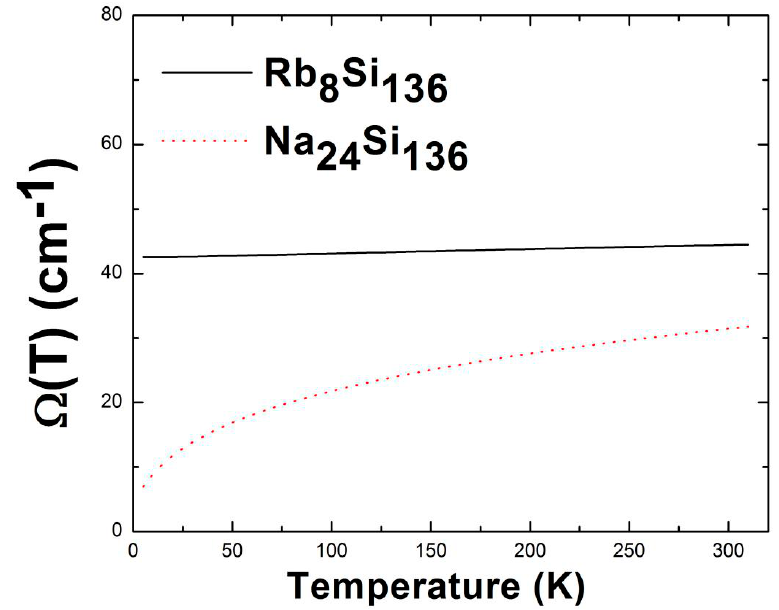
Figure 7. Anharmonic rattling frequency of the guest vibrations in an Si 28 cage as a function of temperature for the filled binary clathrates Rb 8 Si 136 and Na 24 Si 136 .